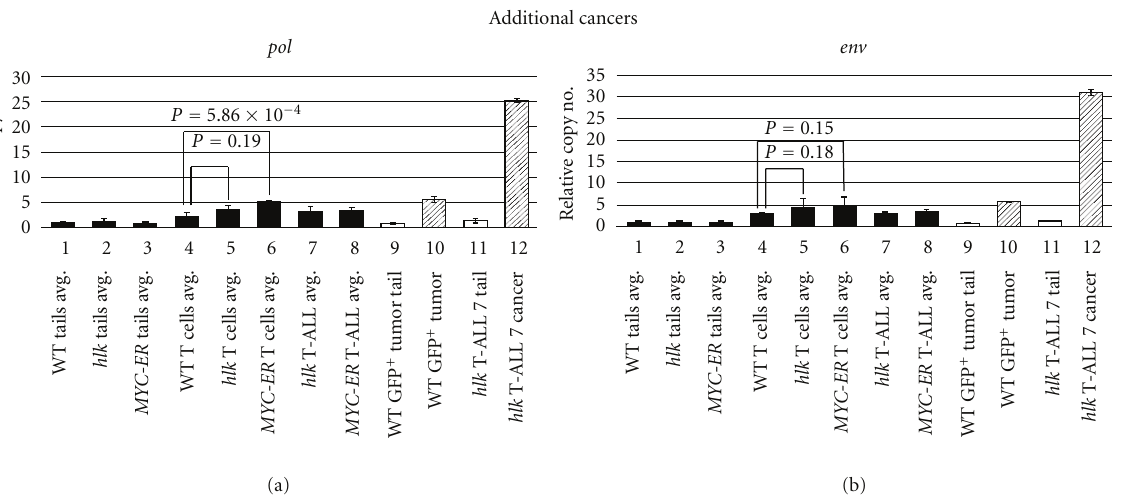
Figure 6: ZFERV amplifications in two other D. rerio T-cell cancers. One WT WIK fish spontaneously developed a GFP + thymic tumor and was tested by qPCR of pol (a) and env (b). Average copy numbers of other samples tested previously are shown as black bars. Germline ZFERV copy number in this fish (lane 9) was similar to the 15 WIK fish already examined (lane 1). This tumor showed 5.5-fold amplification (lane 10, diagonal bar), similar to non-malignant T cells and cancers from WT, hlk , and MYC-ER fish (lanes 4–8). One other hlk T-ALL exhibited high-level, 25- to 30-fold gains (lane 12), although its germline copy number (lane 11) was comparable to other fish (lanes